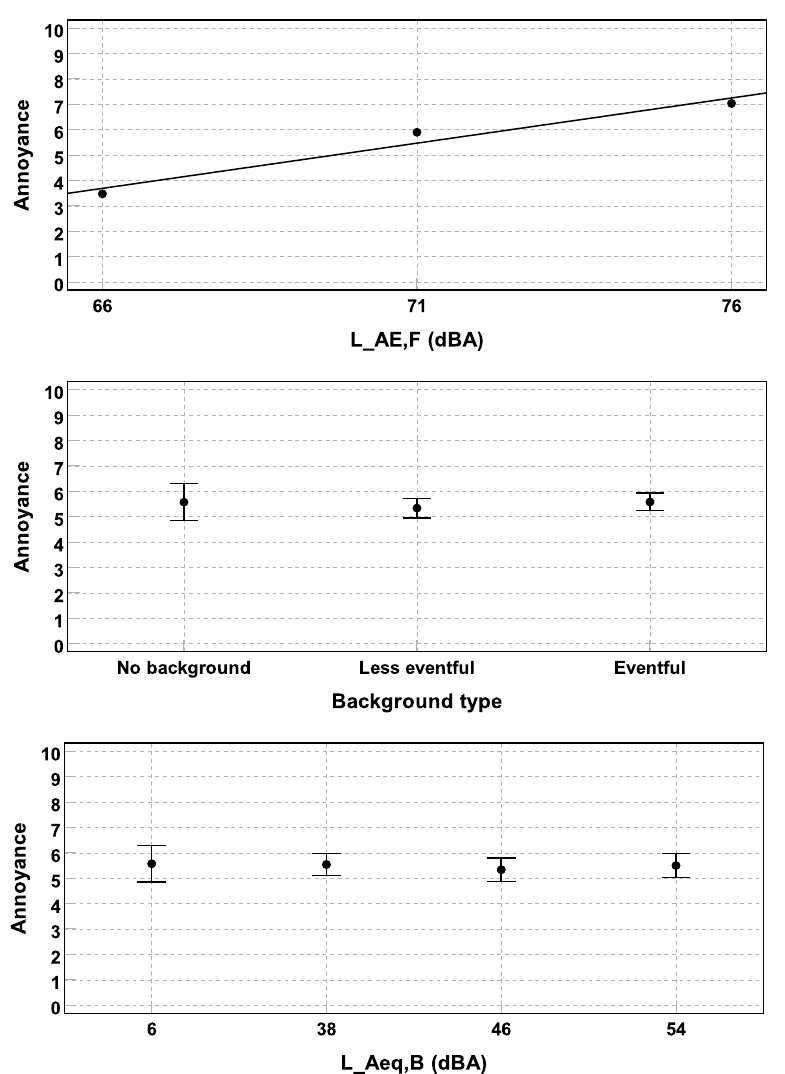
Figure 7. Results of experiment 2: mean acoustic comfort ratings across subjects (and their 95% confidence intervals) are shown as a function of L AE,F ( above ) or for different background types ( middle ) and L Aeq,B ( below